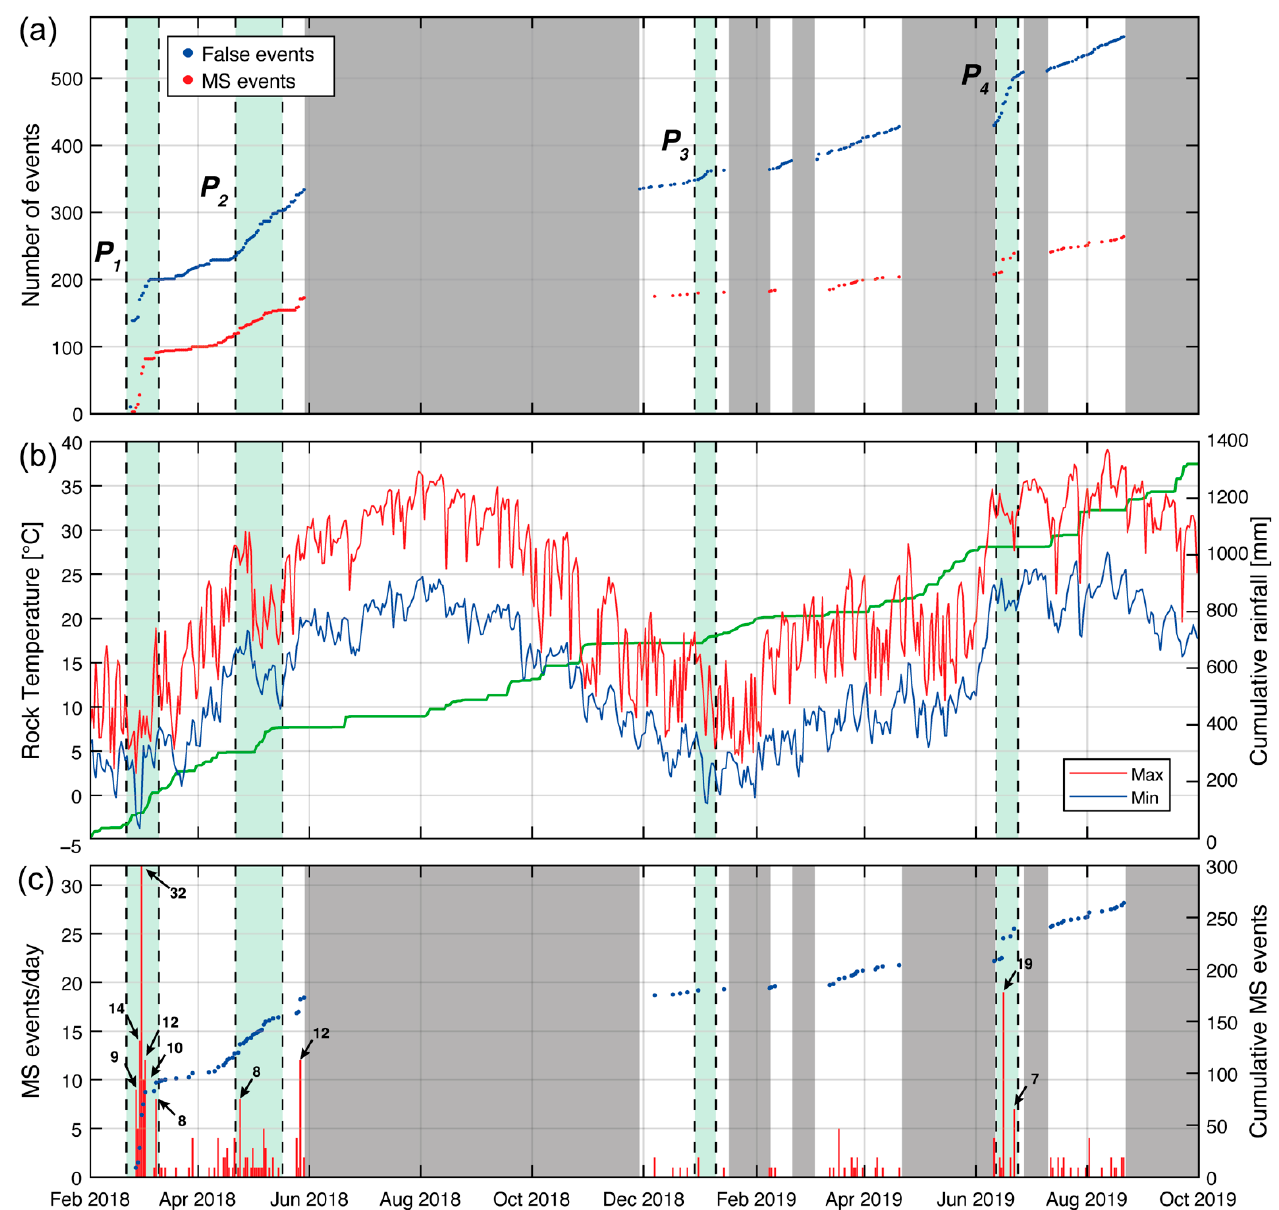
Figure 10. Comparison between the temporal evolution of MS events and environmental factors at the Acuto field laboratory: cumulative number of MS and false events computed over the entire monitoring period ( a ); daily maximum–minimum rock temperature (red and blue lines) and cumu- lative rainfall (green line) ( b ); daily and cumulative number of MS events ( c ). Four time intervals (P1–P2–P3–P4) are highlighted in all plots representing the periods in which the highest increments in both MS and false event occurrence were observed. Gray areas in panels ( a ) and ( c ) represent periods in which the MS monitoring network was not working due to power supply interruptions.